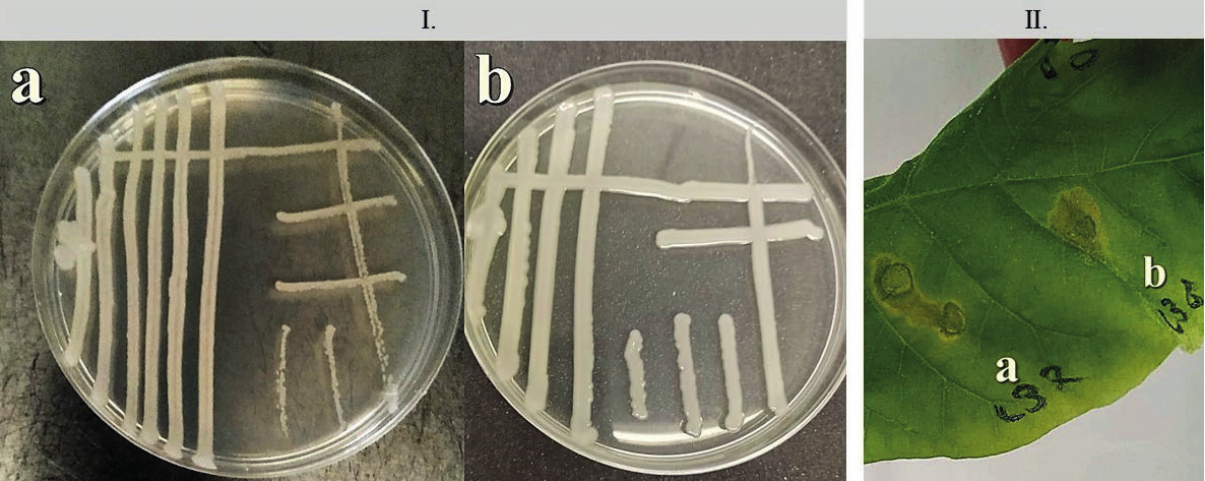
Figure 1. I. Pure cultures of bacterium colonies, after 24 to 48 h on King’s B agar (a, Serratia marcescens isolate Bu-OleS2, and b, isolate Bu- OleS1). II. Hypersensitive reactions from infiltration of tobacco leaves 36 h post-inoculation for inoculations with, a, isolate Bu-OleS2 or b, isolate